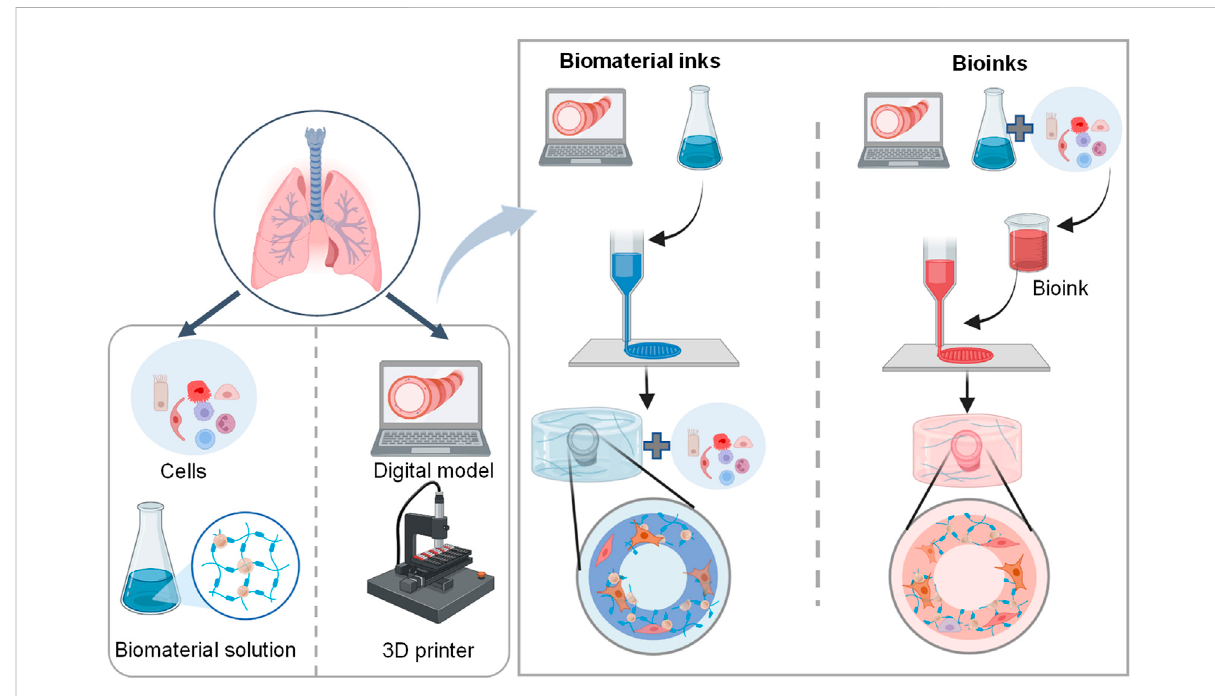
FIGURE 4 Schematic representation of the 3D lung bioprinting process. The general process of 3D bioprinting contains three steps: acquisition of a 3D CAD model, automated deposition of biomaterials (referred to biomaterial inks) or the mixture of cells and biomaterials (referred to bioinks), and maturation of cell-laden constructs to mimic desired tissue constructs (Barreiro Carpio et al.,